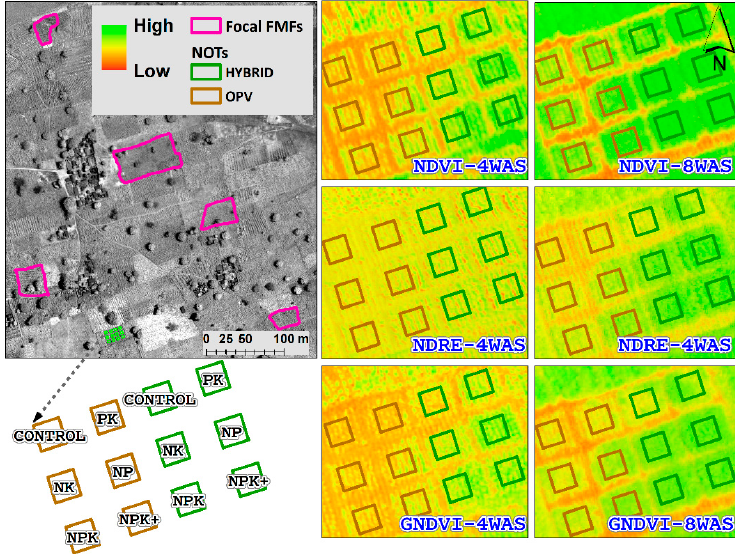
Figure 5. Vegetation indices (VIs) derived from UAV-sensed multispectral imageries, covering maize plots within nutrient omission trials (NOTs) and farmers’ fields at Bunkure, Kano. The grey imagery shows red-edge reflectance band acquired at 8 weeks after sowing (WAS), while the colored imageries show the VIs at 4 and 8WAS.